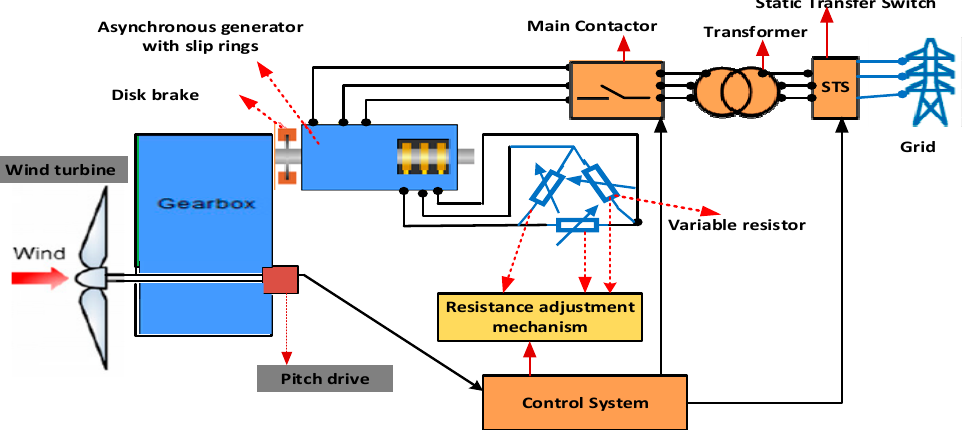
Figure 8. Schematic diagram of a slip control for a wind turbine.